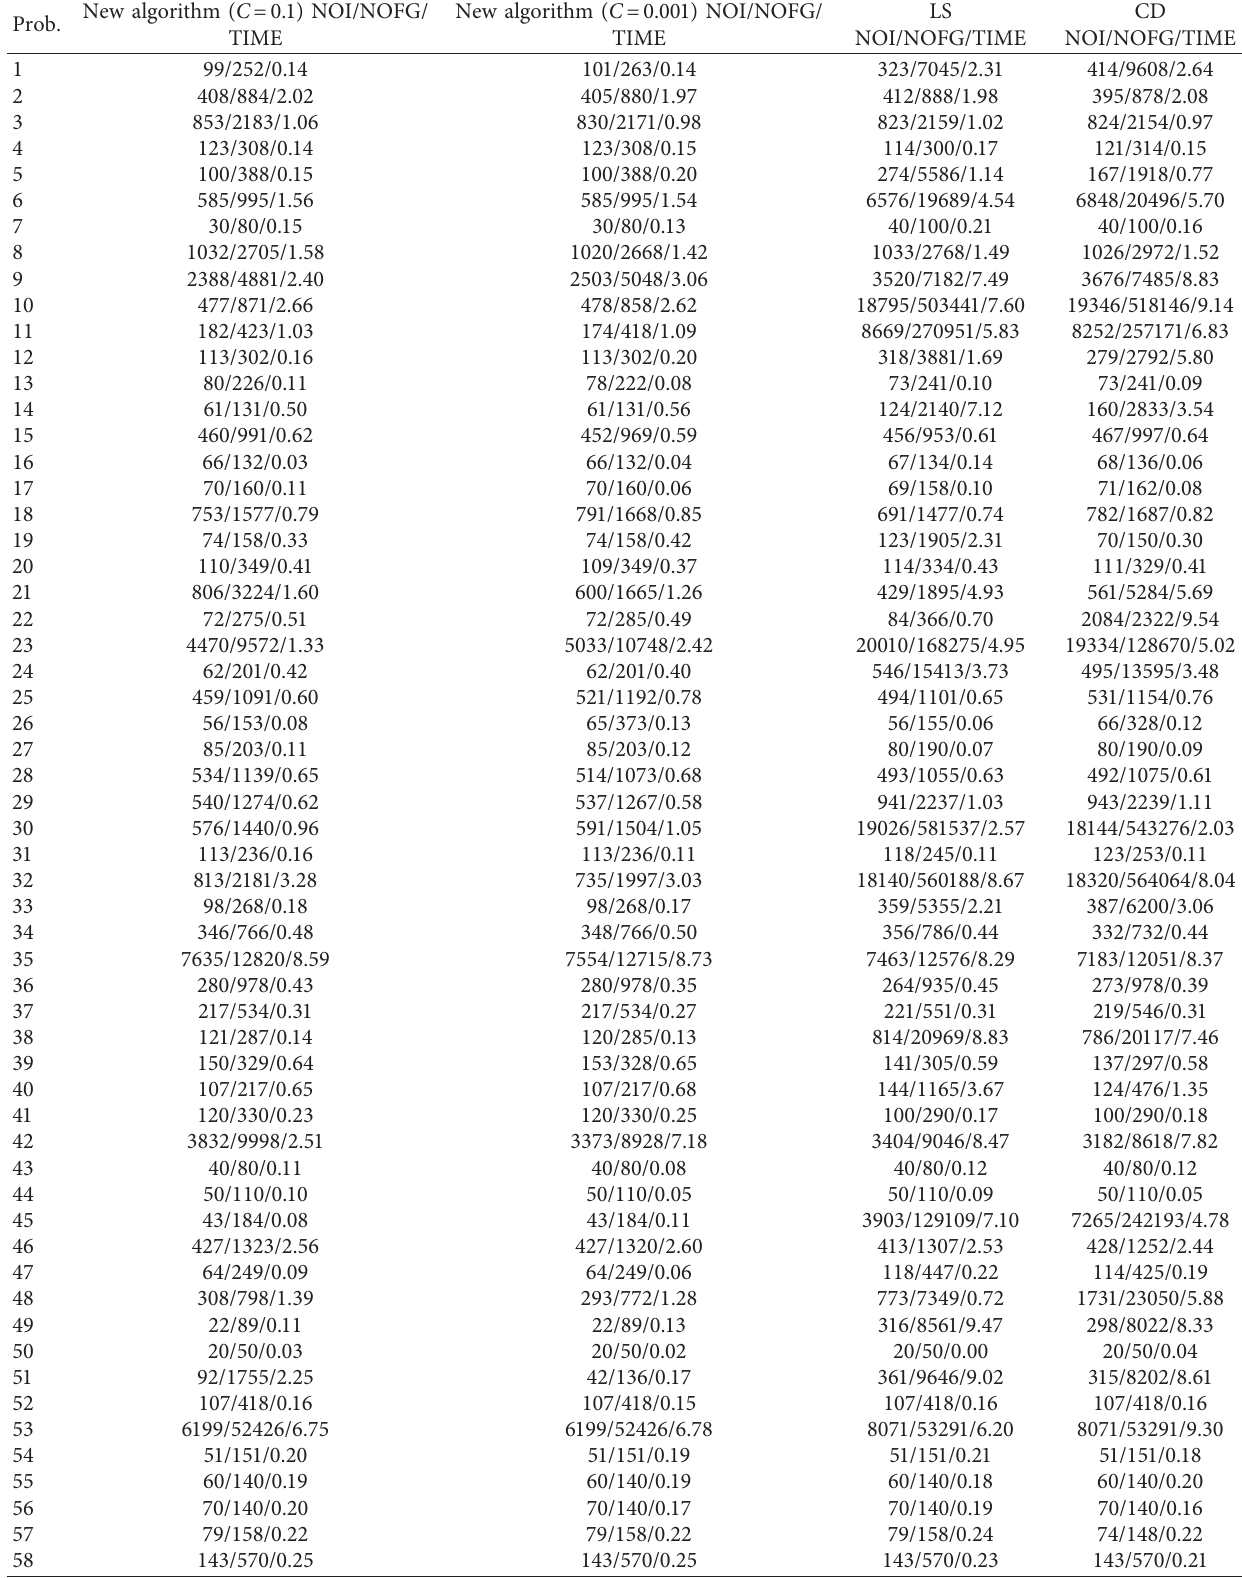
Table 1: Comparisons of new algorithm against (LS) & (CD) algorithms for the total of (60) test problems with (1000 ≤ n ≤ 10000, and the increasing size in n is equal to 1000) with ( c � 0.1 and 0.001). New algorithm ( C � 0.1) NOI/NOFG/ Prob.